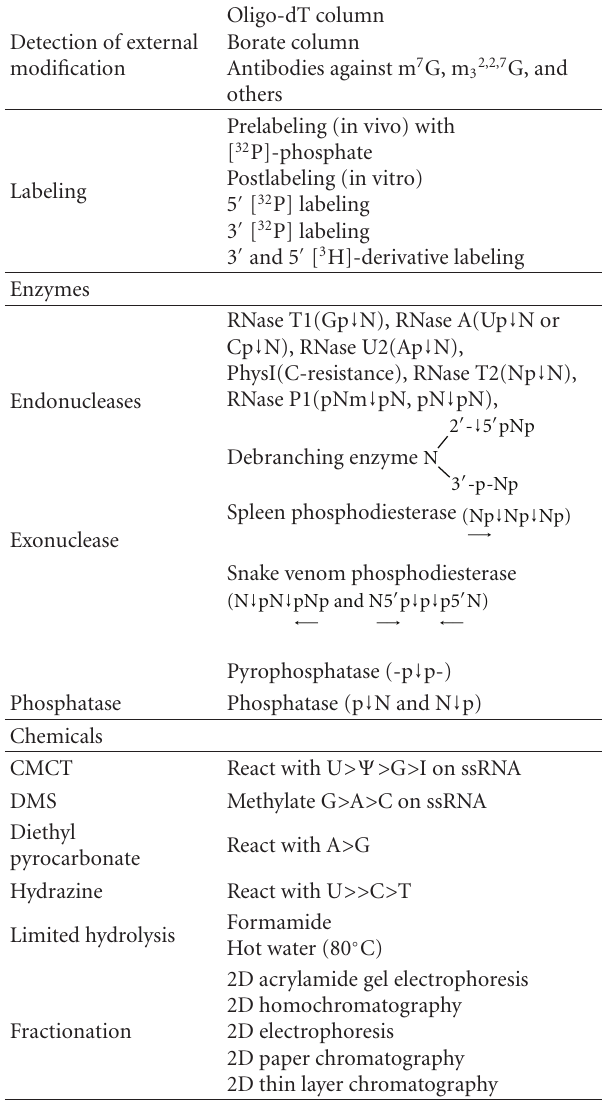
Table 7: Reagents and procedures required for sequencing.